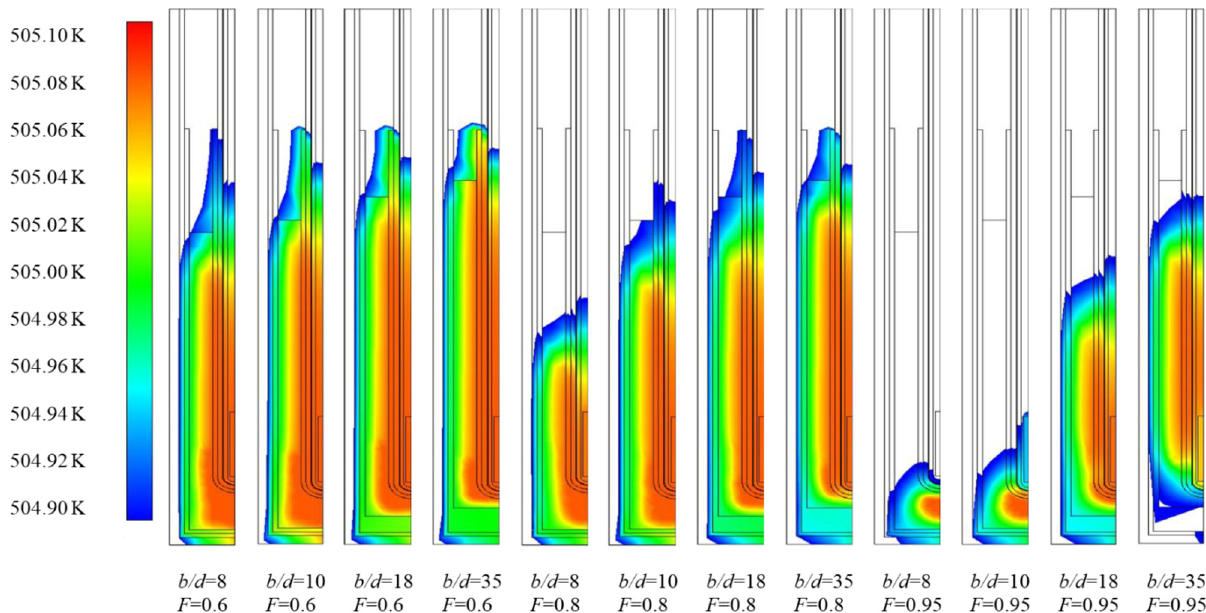
Fig. 9. Temperature pro fi les of different b / d ratios for solid fraction F between 0.6 and 1 (white sections represent temperatures lower than